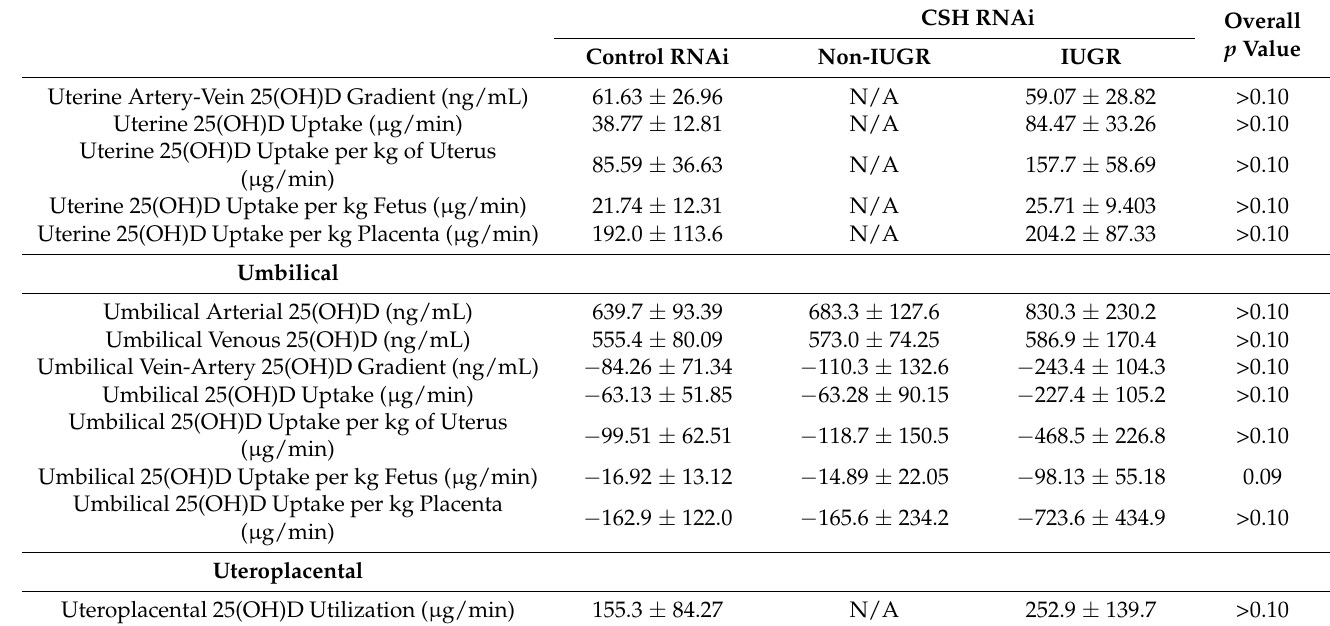
Table 2. Effect of CSH RNAi on serum 25(OH)D abundance. Data are presented as means ± SEM. Different superscripts indicate statistical significance. (Control RNAi n = 4–10; CSH RNAi Non- IUGR n = 6; CSH RNAi IUGR n = 4). CSH, chorionic somatomammotropin; IUGR, intrauterine growth restriction; N/A, samples/results not available; RNAi, RNA interference.